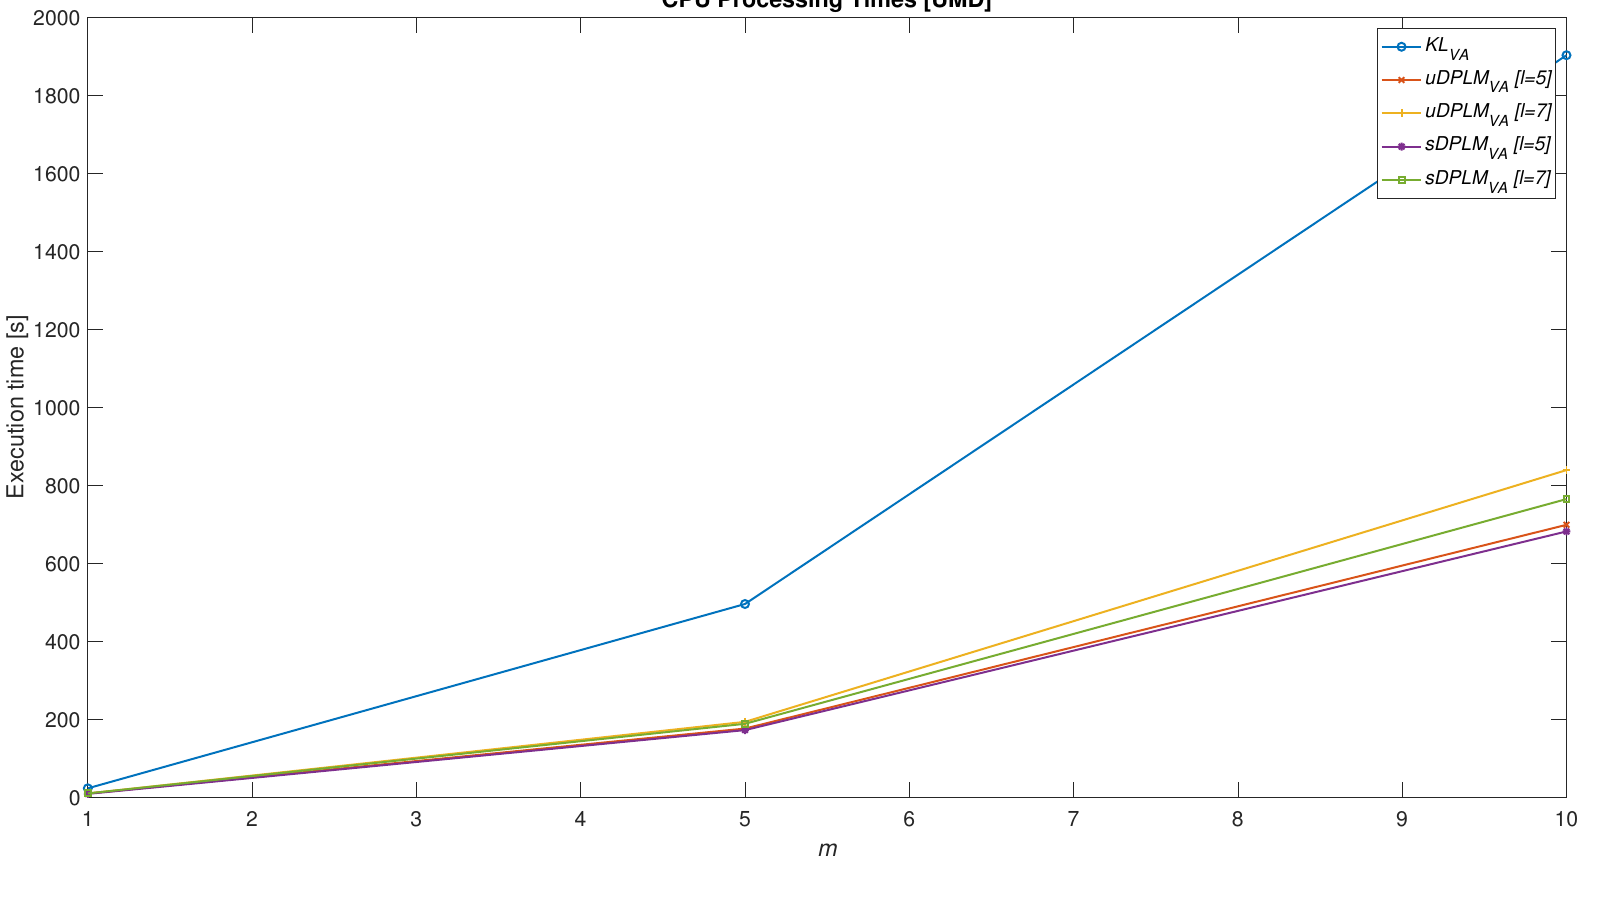
Figure 10. CPU processing times for the UMD database, DPLM VA vs. KL VA